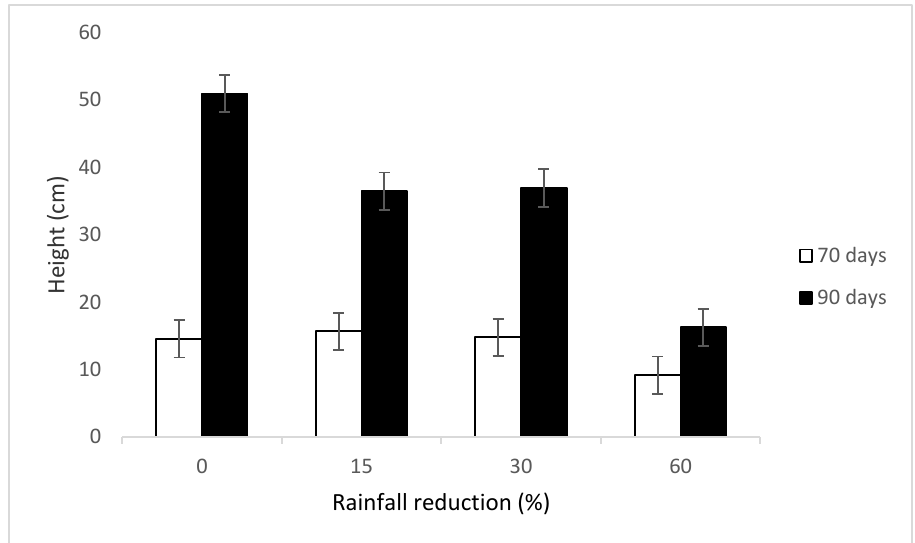
Figure 3. Interaction effect of rainfall reduction and resting period on vegetation sward height in spring 2016/17 (bars indicate standard error values).